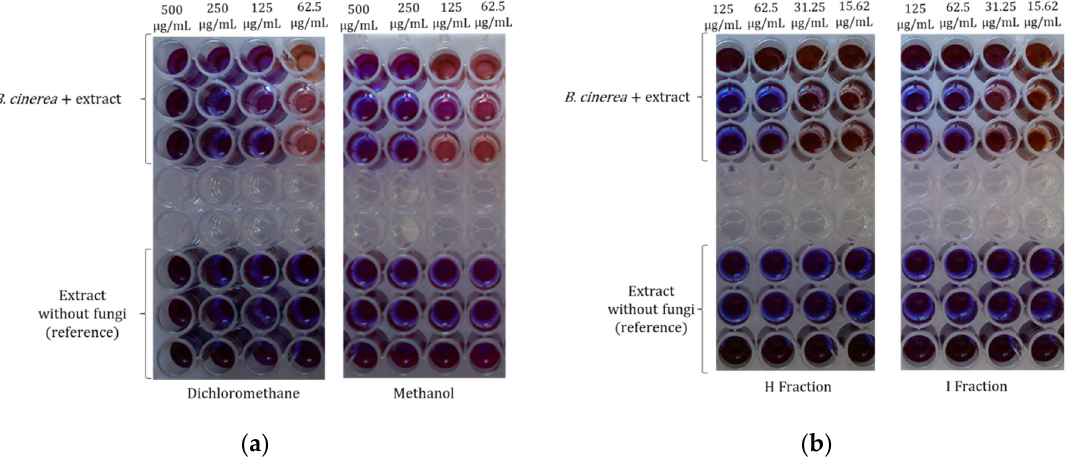
Figure 4. Microplate analysis of resazurin data from extracts and fractions against Botrytis cinerea : ( a ) dichloromethane and methanol extracts at gradient concentration keep the inhibition at 125 ppm and 250 ppm, respectively; ( b ) fractions H and I from B. trinervis at gradient concentration keep the inhibition at 62.5 ppm.